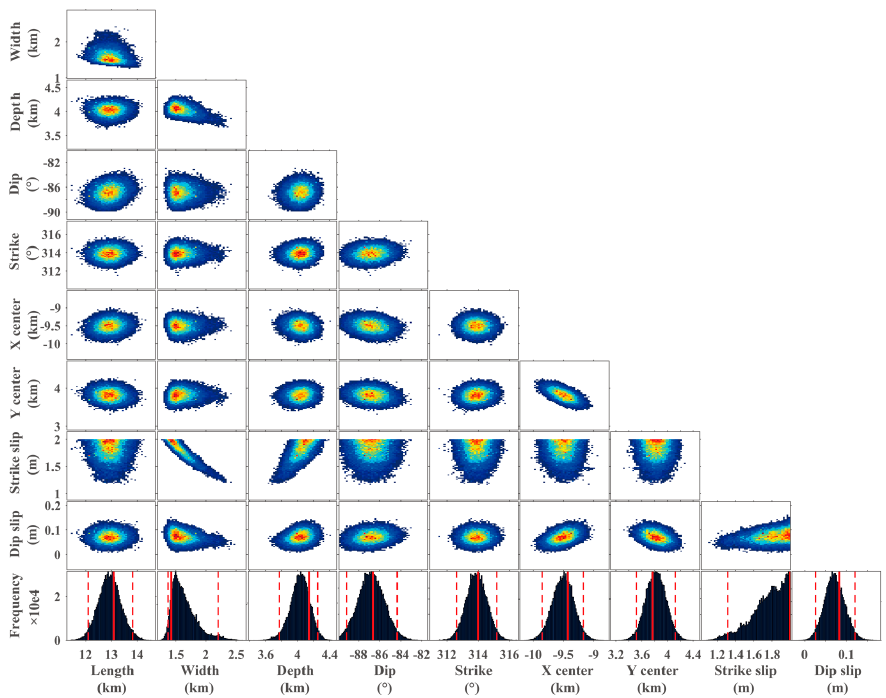
Figure 6. 1-D and 2-D posterior PDF plots of the fault geometry parameters of the 2021 Yangbi earthquake. The bottom row is the histograms of the marginal probability density distribution for each parameter. Red solid lines represent the maximum a posteriori probability solution and red dashed lines denote the 95% confidence interval bounds.